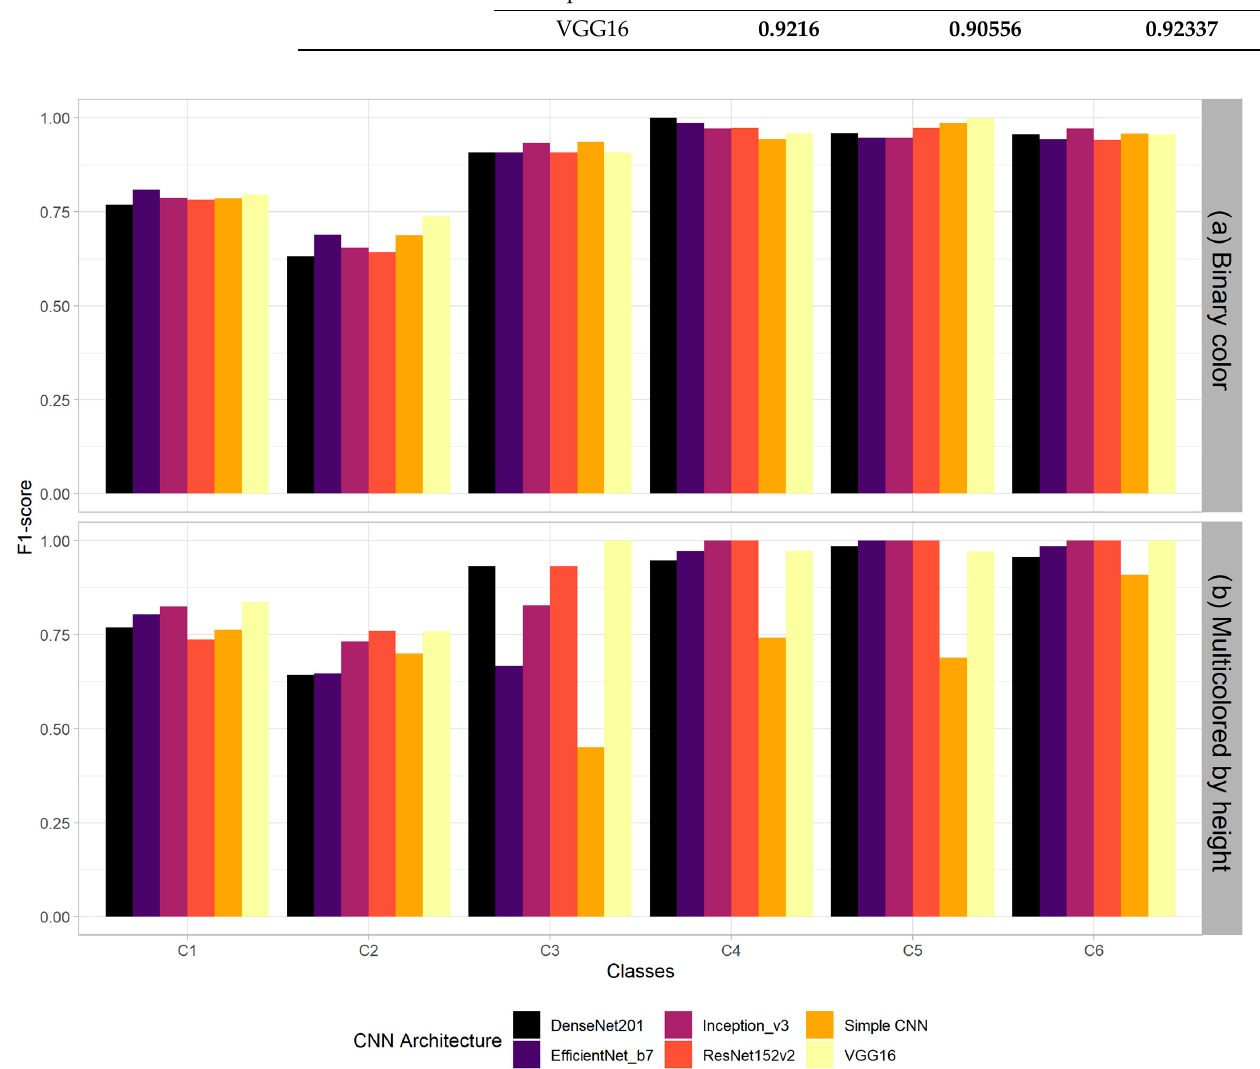
Figure 5. F1 score for each CNN architecture across post-hurricane damage severity categories. ( a ) binary-colored images; ( b ) multicolored images by